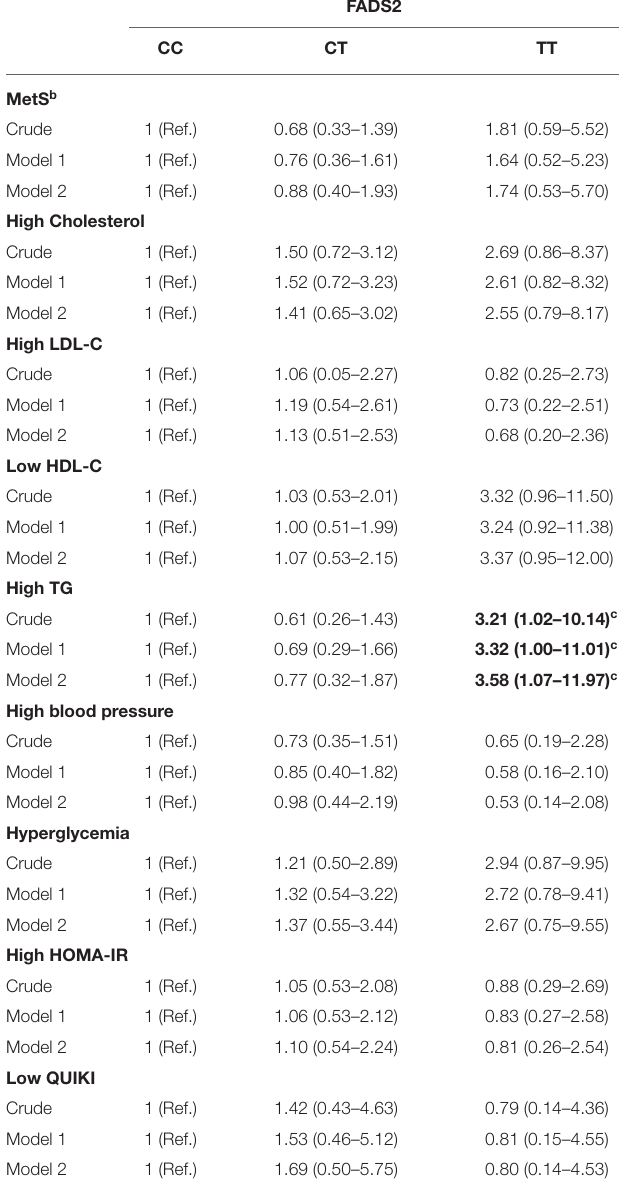
TABLE 6 | Odds ratio (OR) and confidence interval (CI) for FADS2 rs174583 genotypes and cardio-metabolic risk factors a of participants.